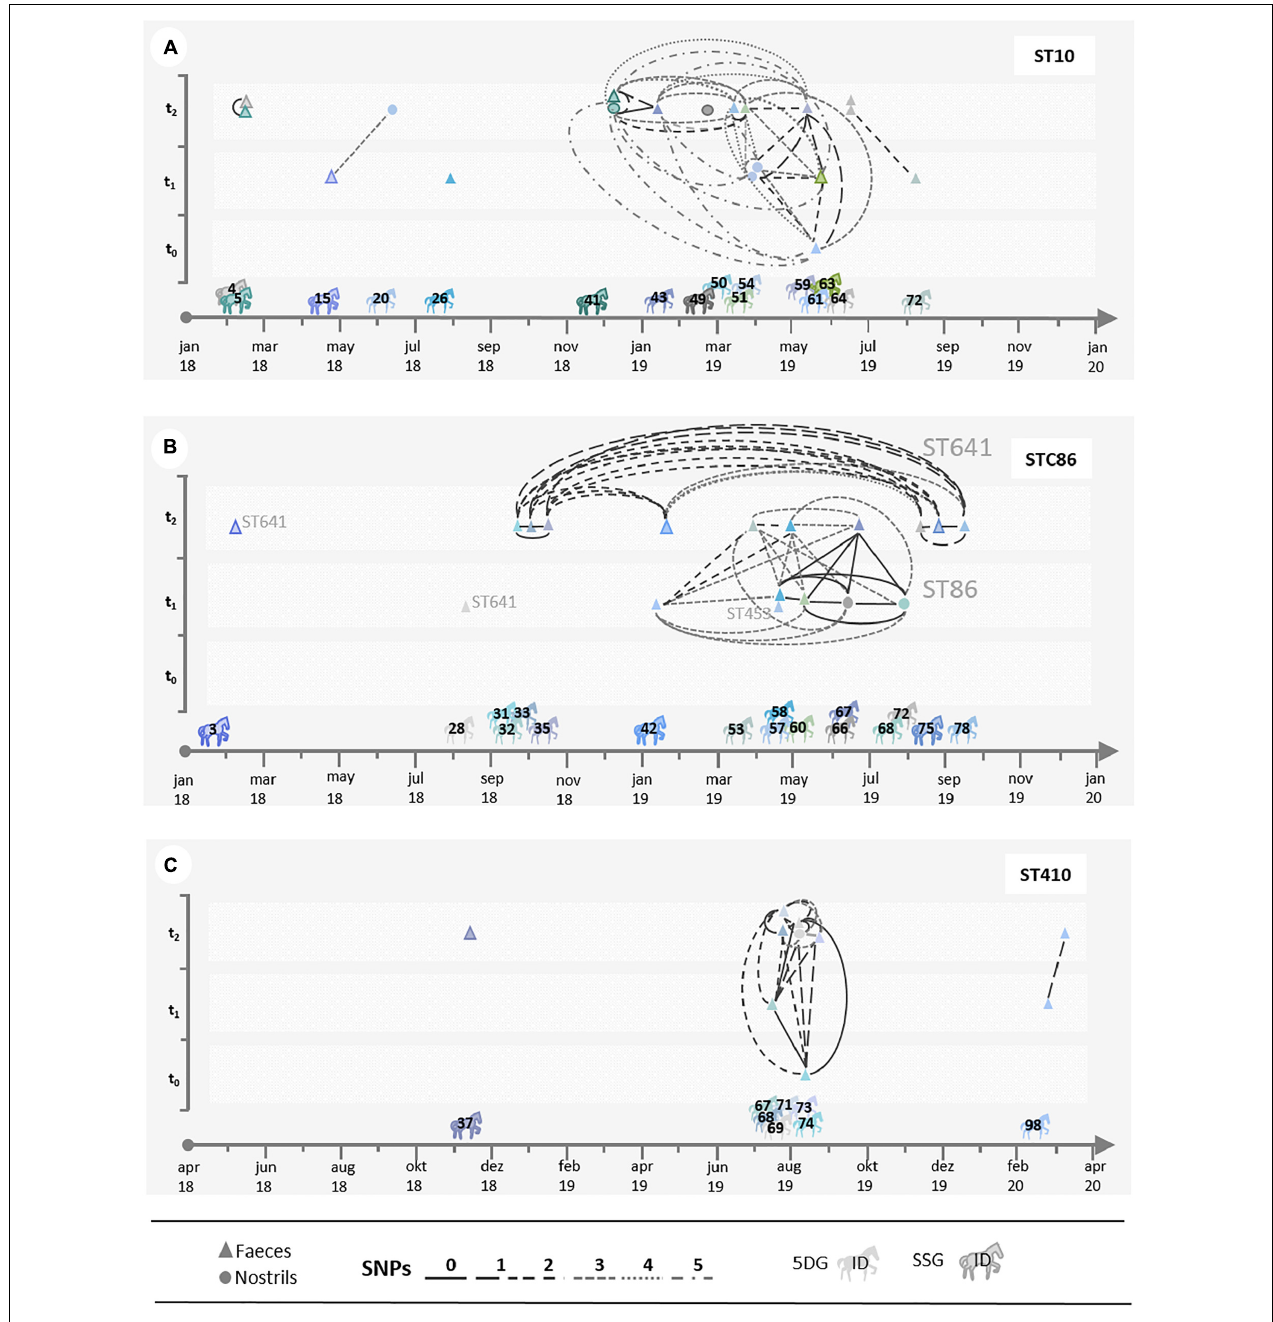
FIGURE 5 | Local spread of distinct ESBL-EC. The illustrations (A–C) show scatter plots displaying SNP distances calculated for the most prevalent ESBL-EC lineages on a time scale. In order to assess the possible phylogenetic and temporal relationships between the isolates, isolates of each horse (indicated by its identification number (ID)) share a particular color. Isolates gained from nostril swabs are indicated by circles, fecal isolates by triangles. The number of SNPs between two isolates is marked with a specific line. (A) Shows all isolates belonging to ST10; (B) STC86 (ST641 and ST86); and (C)